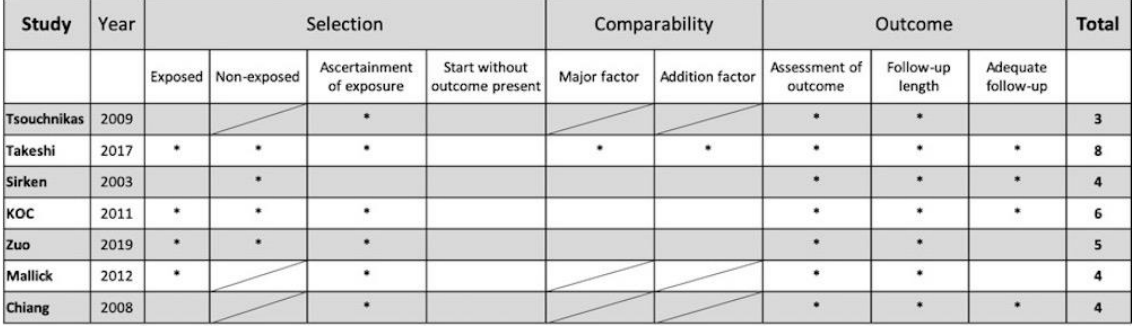
6 of 12 Figure 2. Risk of bias of randomized controlled trials.